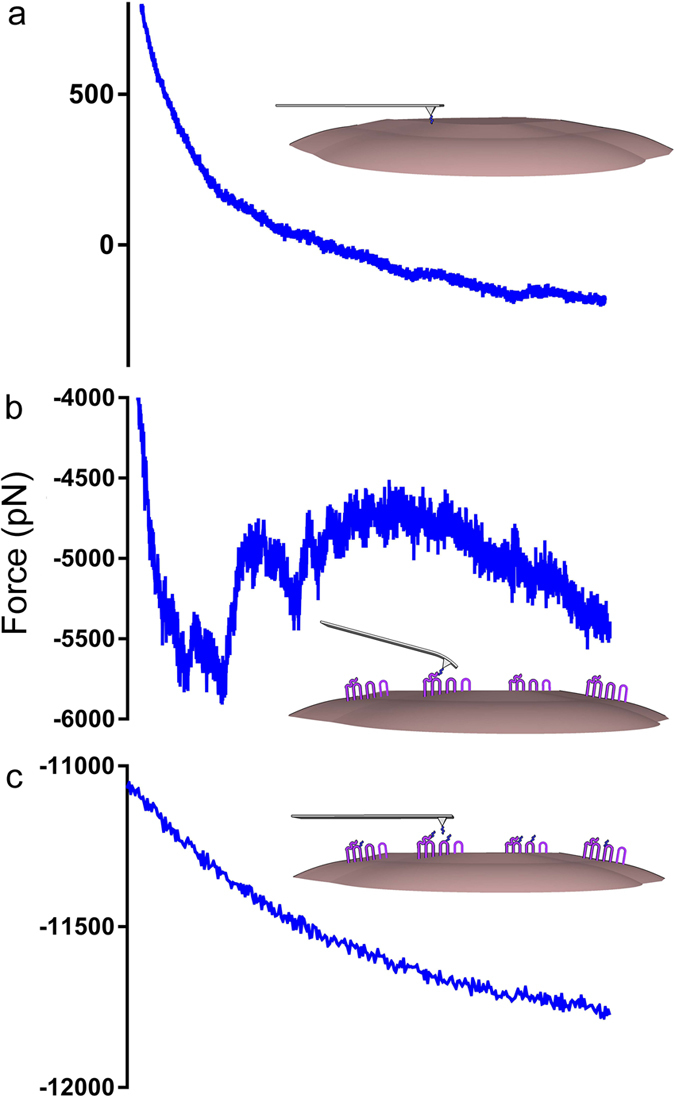
Specific interaction between AST-C and CamAlstR-C.Huh7 cells were transfected with empty plasmid (a) or CamAlstR-C construct (b,c). (a) Huh7 cells that were transfected with empty plasmid did not show unbinding events in AFM experiments. (b) CamAlstR-C expressing cells showed specific unbinding events with AST-C peptide. (c) After peptide wash of CamAlstR-C expressing cells, the unbinding events were lost again.